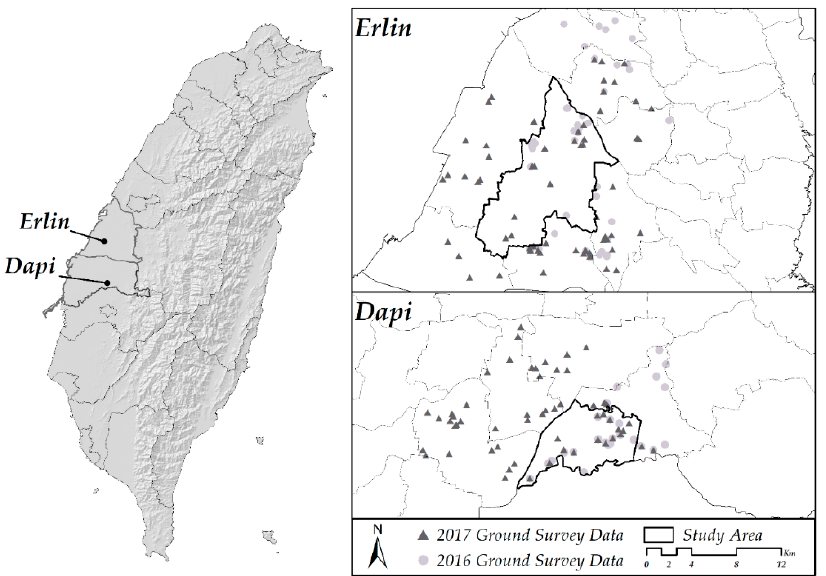
Figure 3. Ground survey data’s distribution maps for Erlin and Dapi.